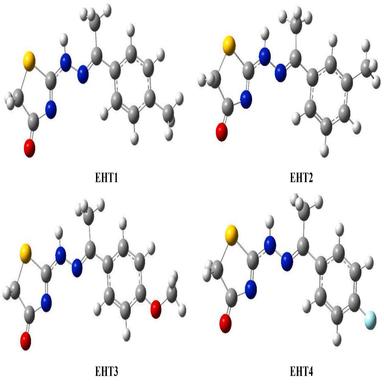
The optimized structures of entitled chromophores (EHT1-EHT5).